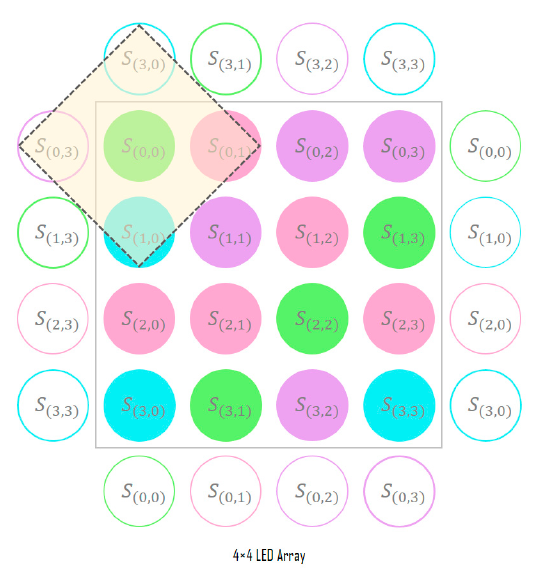
Figure 5. Adjacent symbol area at the LED array boundary.